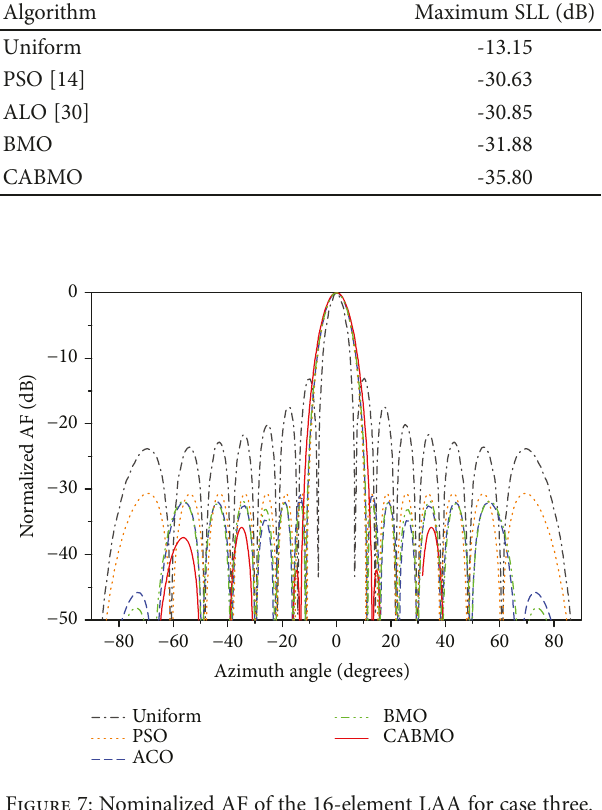
Table 7: The maximum SLL of the 16-element LAA for case three. Algorithm